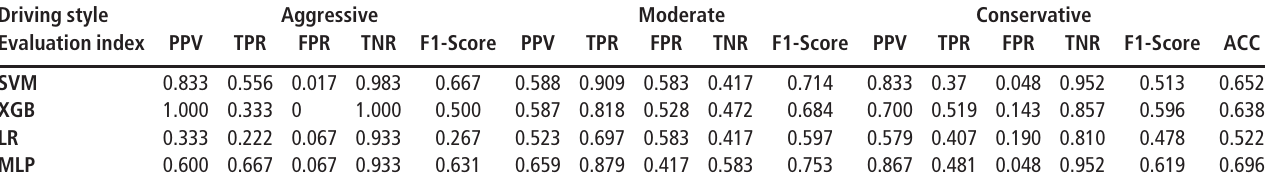
Table 9 The prediction results of different machine learning models Driving